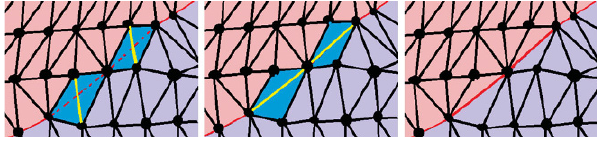
Fig. 3 Edge flipping. Red: Segmentation curve. Left: Before flipping. Yellow edges are flipable. Centre: After flipping. Right: Face labeling after edge flipping.